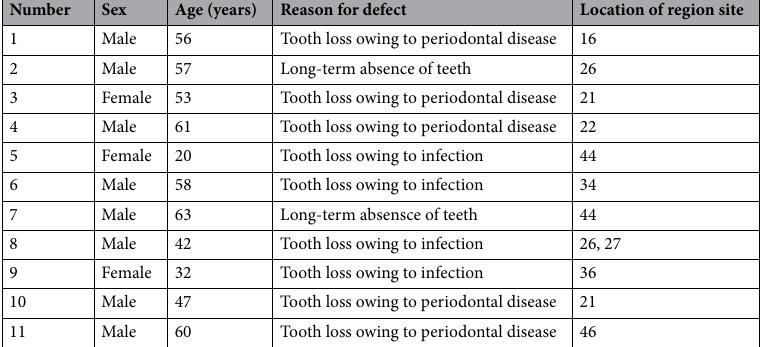
Table 1. Characteristics of the study